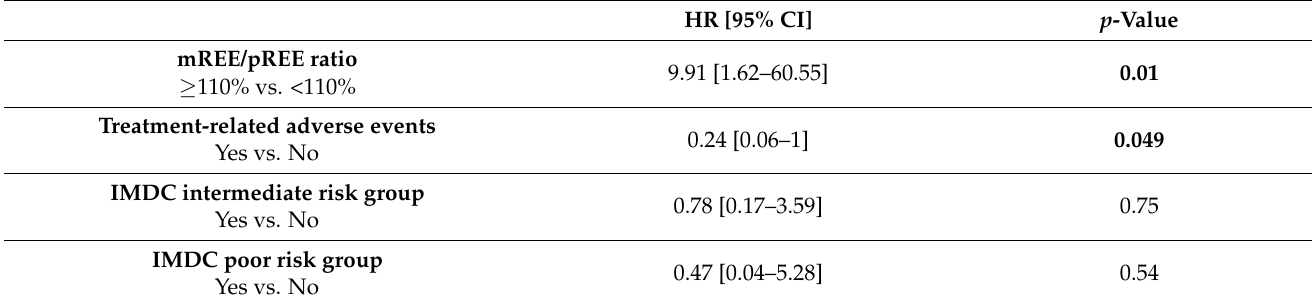
Table 3. Multivariate analysis for 6-month progression-free survival.